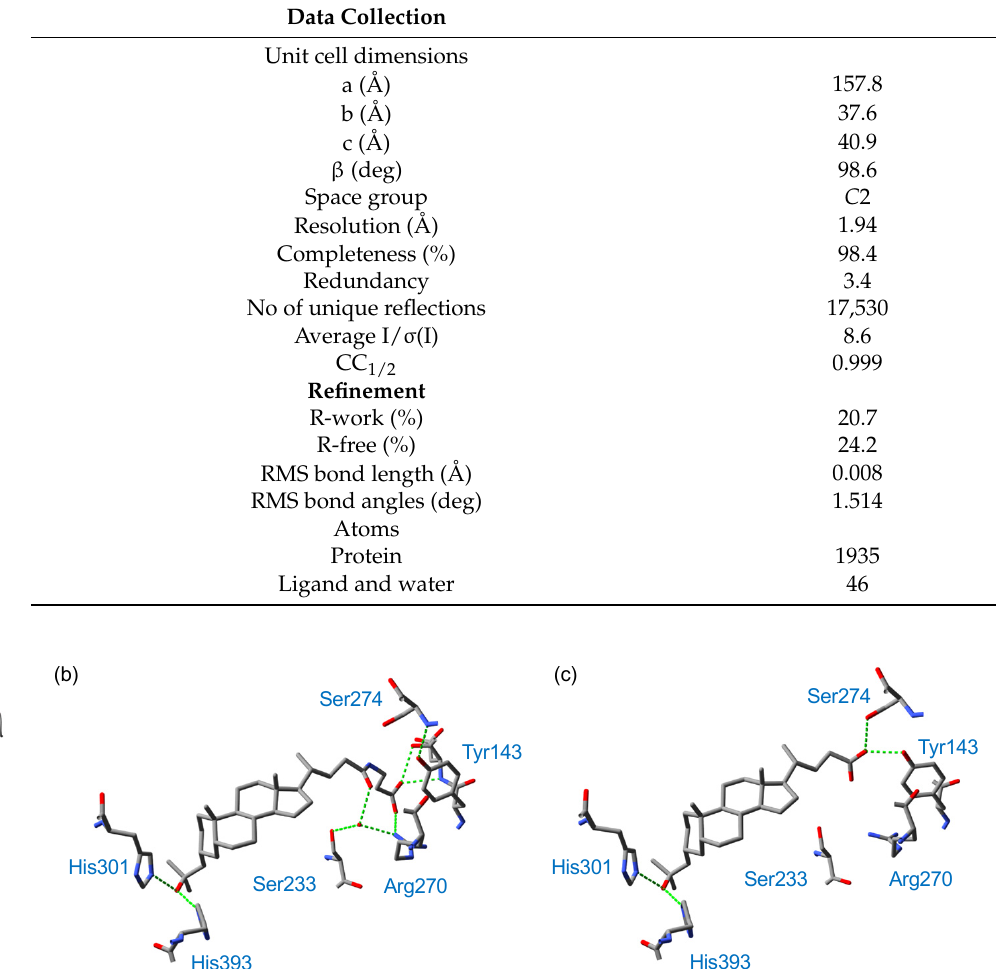
Table 2. Data collection and refinement statistics for the crystal structure of VDR LBD bound to 7b and coactivator peptide. Values in parentheses are for the highest-resolution shell.